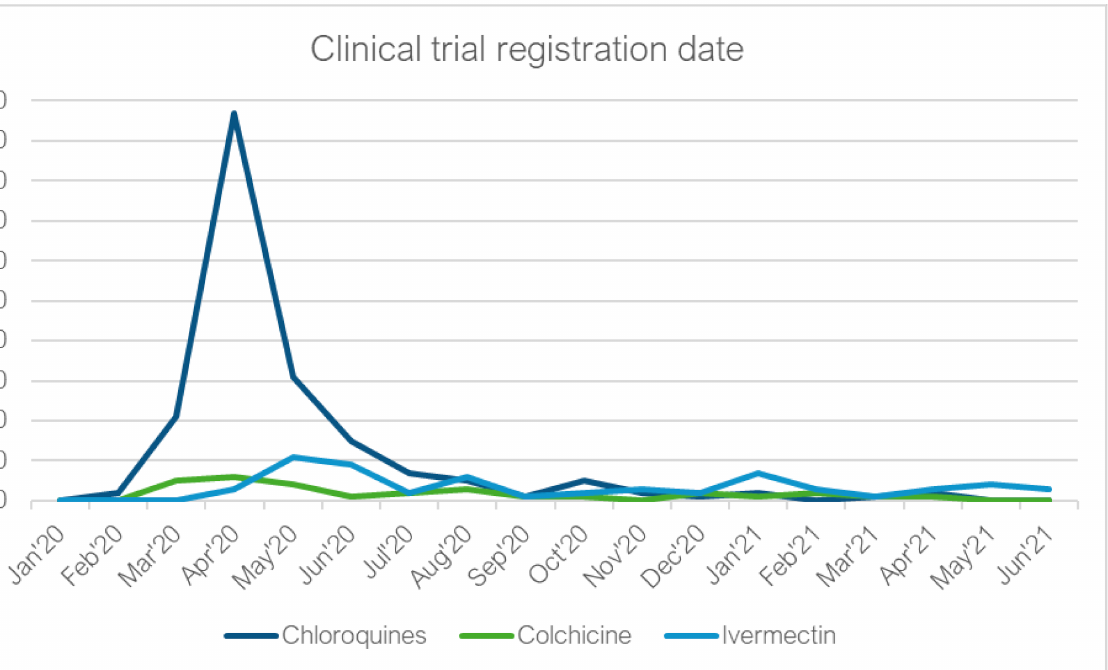
Figure 7. The number of clinical trials registered each month from January 2020–June 2021 for the chloroquine, colchicine and